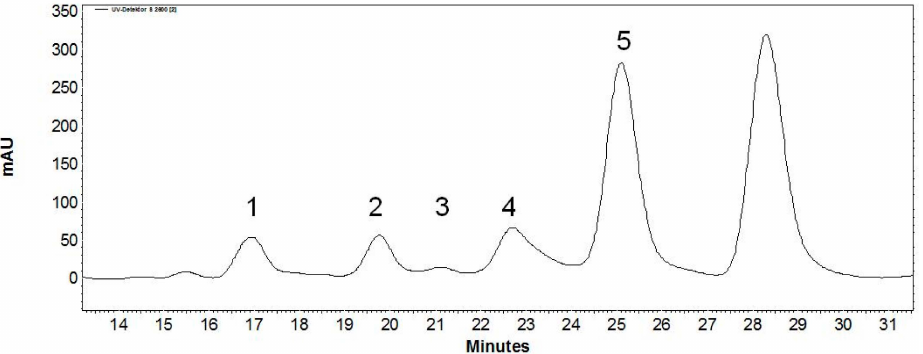
Figure 2. Semi-preparative Reversed-Phase (RP)-HPLC separation of pooled product fractions from transgalactosylation reactions of recombinant β -glycosidase from Pyrococcus . 10 mM β - D -GlcNAc-linker- t Boc, 600 mM lactose and 12 U/mL enzyme solution were incubated for 30 min at 85 ˝ C under conventional thermal heating. Single product peaks were collected and analyzed by analytical RP-HPLC, enzymatic digestion, ESI-MS measurements and NMR spectroscopy (see supplementary materials).